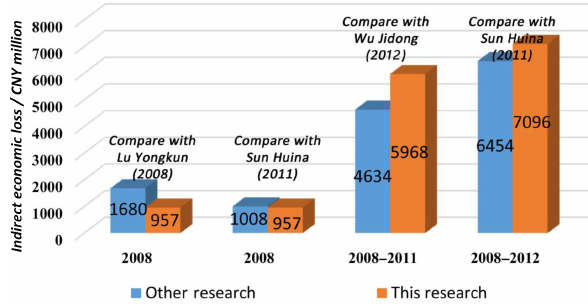
Figure 13. Comparison of indirect loss with other